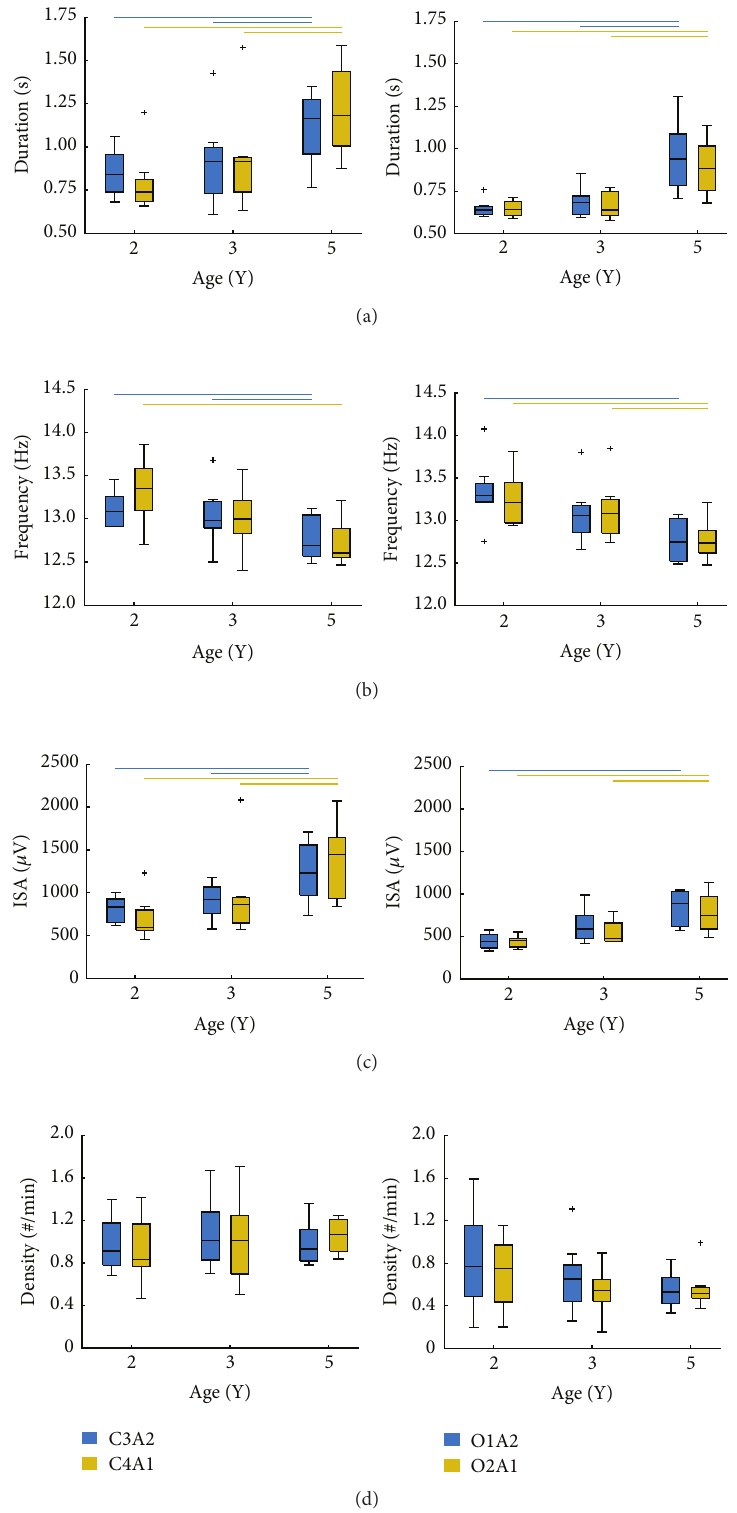
Figure 2: Boxplots of sleep spindle duration (a), frequency (b), integrated spindle amplitude (ISA; (c)), and density (d) at ages 2, 3, and 5 years for each EEG derivation (C3A2, C4A1, O1A2, and O2A1). Upper and lower borders of boxplots represent upper and lower quartiles, tails represent minimum and maximum scores, the vertical midline represents the median, and outliers are indicated by +. Lines at the top of each plot denote significant post hoc paired 𝑡 -test comparisons (Bonferroni correction; 𝑝 < 0.016